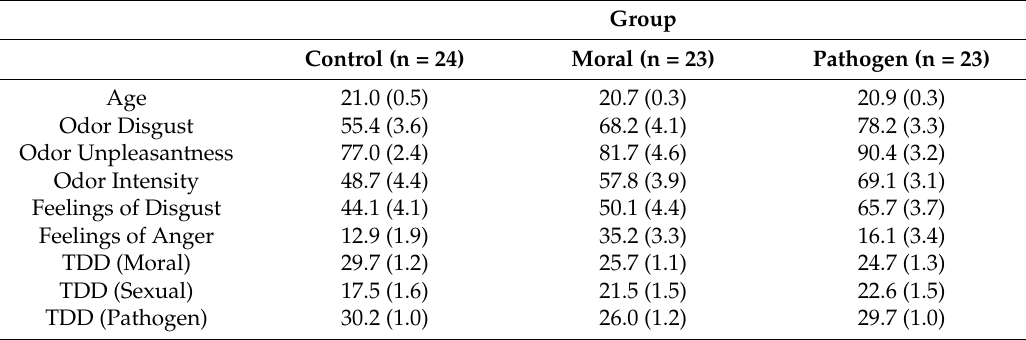
Table 3. Mean (SE) Participant Characteristics and Effects on Emotion (Experiment